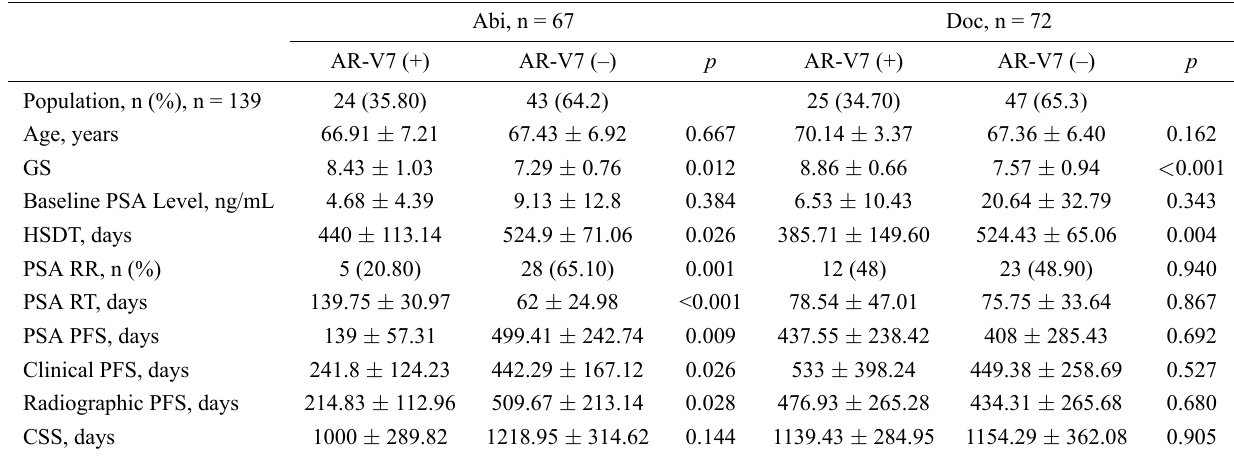
Table 2. Clinical characteristic and time-to-event outcomes according to AR-V7 status in Abi- and Doc-treated